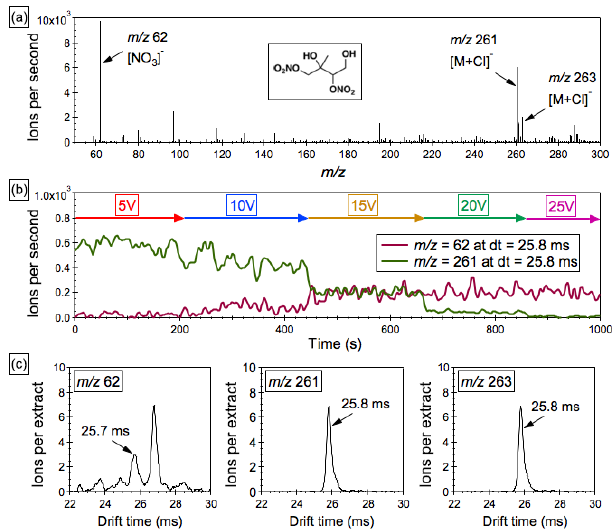
Figure 6. (a) The “mobility-selected” mass spectra of the parent ion adduct at m/z 261 and its major fragment at m/z 62 in iso- prene SOA extracts with ∼ 0 . 2mM sodium chloride as the additive. (b) Profiles of the precursor ion adduct at m/z 261 and its product ion at m/z 62 as a function of the CID voltage. (c) Drift-time spec- tra of the ion adduct at m/z 261, its isotope ion adduct at m/z 263 and the fragment ion at m/z